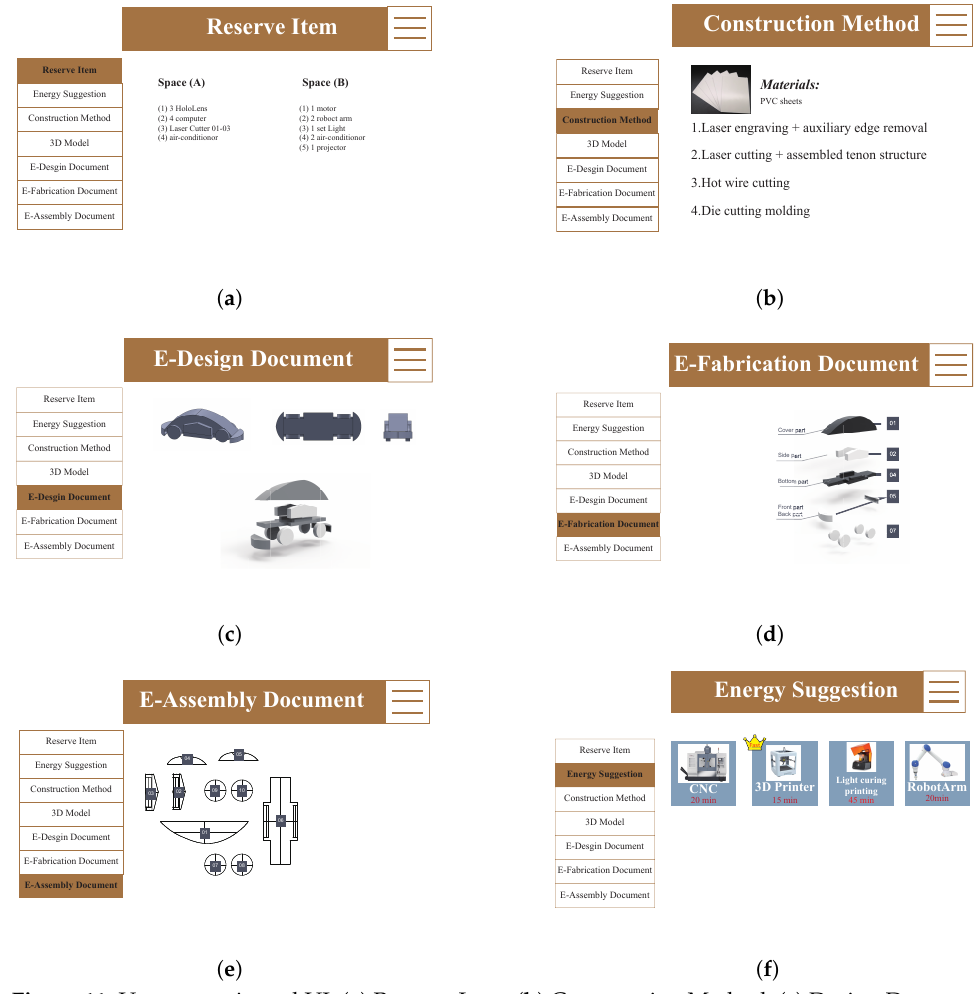
Figure 11. User scenario and UI. ( a ) Reserve Item; ( b ) Construction Method; ( c ) Design Document; ( d ) Fabrication Document; ( e ) Assembly Document; ( f ) Energy